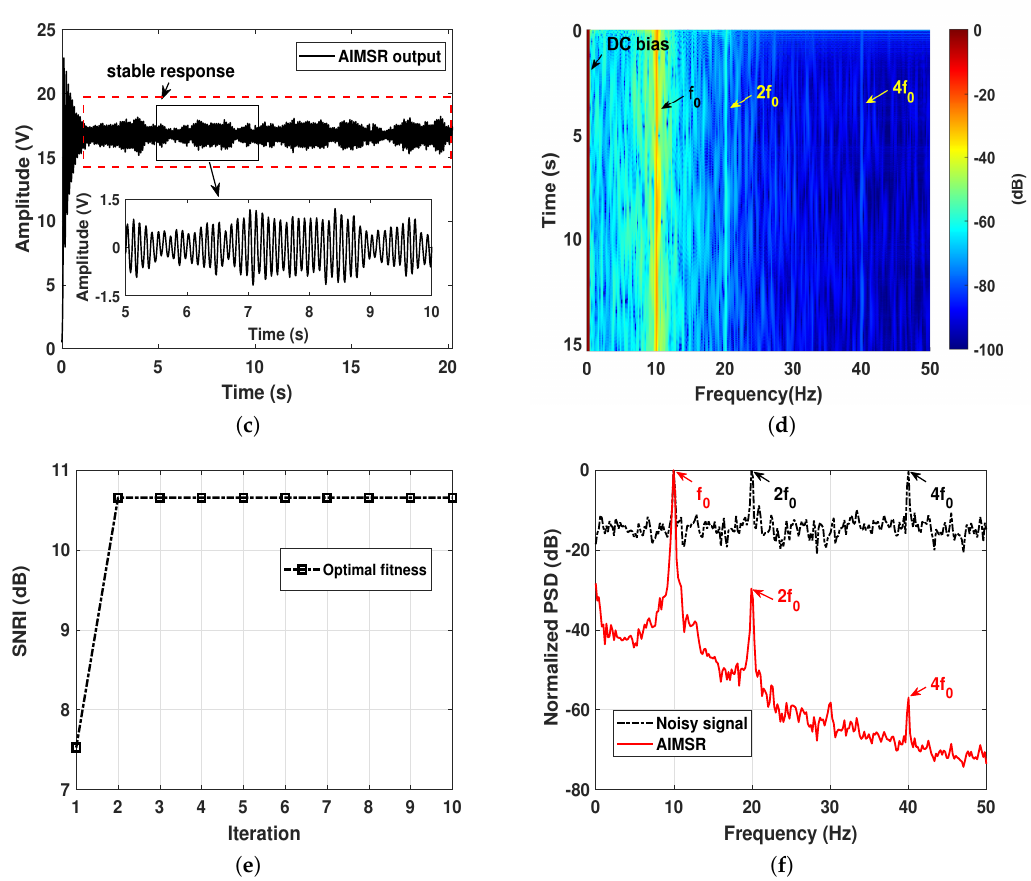
Figure 4. A simulation of harmonic-related line signature signals on H 1 assumption: ( a ) the input waveform and its normalized power spectrum; ( b ) lofargram obtained with the input; ( c ) the AIMSR output waveform ( γ opt = 0.1132, K opt = 70.4507, h opt = 0.4429); ( d ) lofargram obtained with the AIMSR output; ( e ) the optimal fitness at each iteration with GA; ( f ) filtering performance comparison with normalized PSD (Welch method).